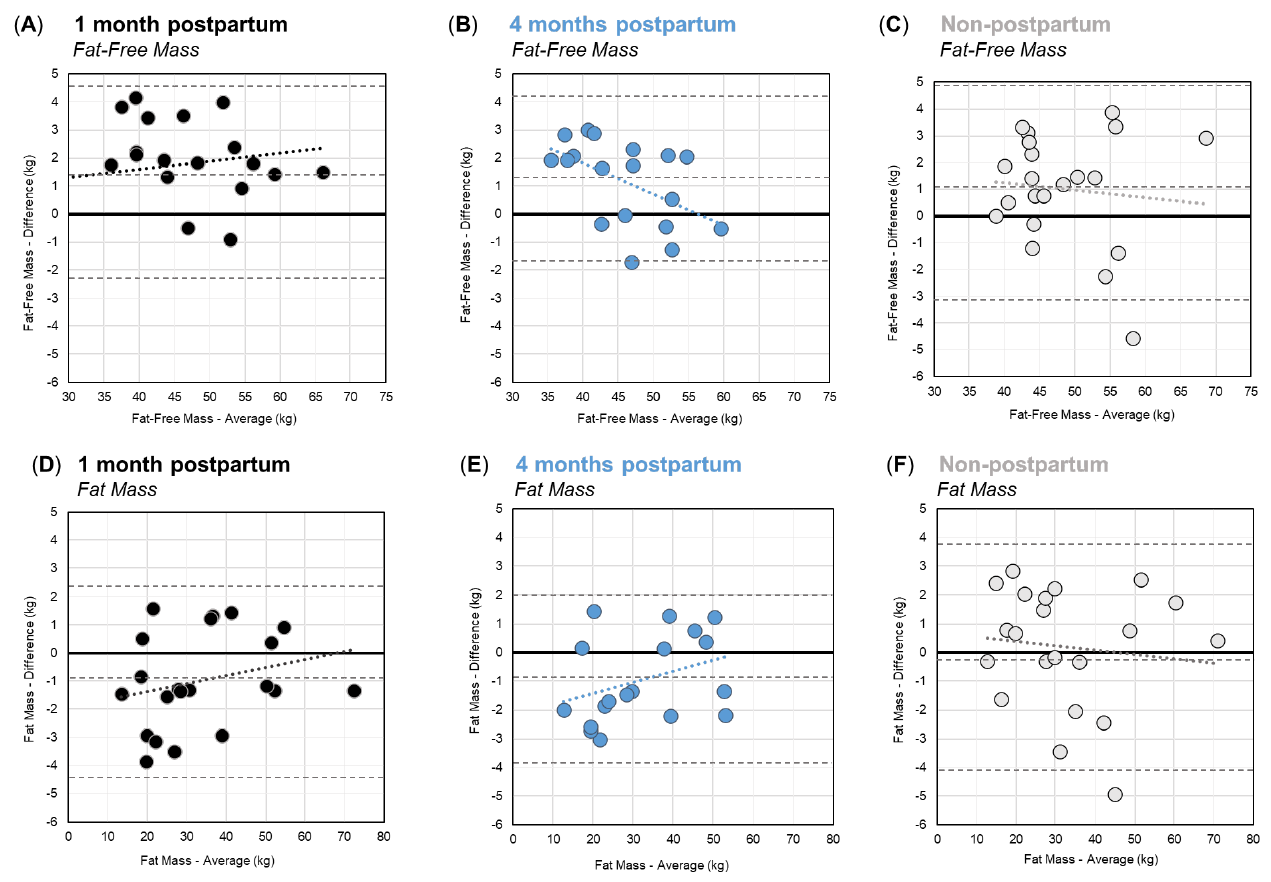
Figure 2. Bland – Altman Plots for Fat-Free Mass ( A – C ) and Fat Mass ( D – F ) for women at one month postpartum (black), four months postpartum (blue), and the non-postpartum control group (grey). Dashed lines show the respective mean differences and limits of agreement.